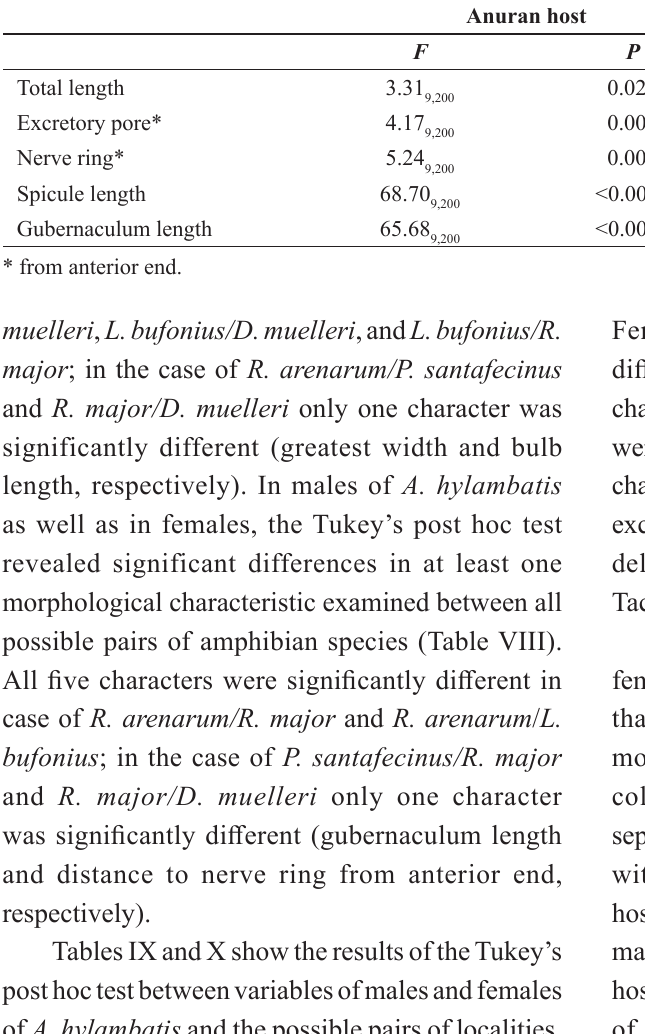
Summary of one-way analysis of variance of males of A. hylambatis between morphological characters and anuran hosts and